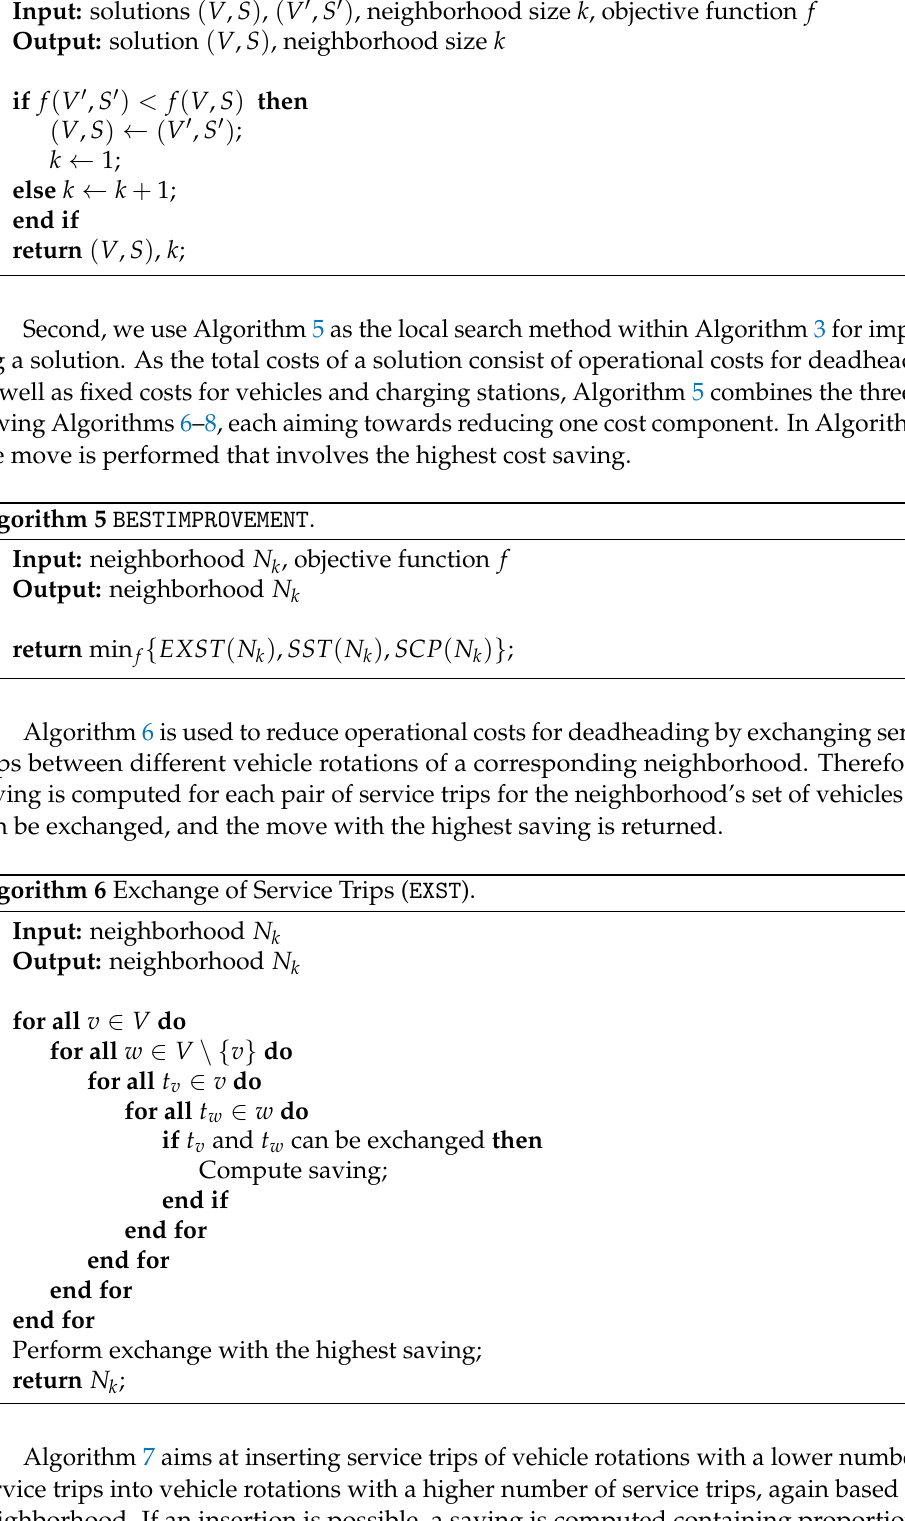
Algorithm 7 aims at inserting service trips of vehicle rotations with a lower number of service trips into vehicle rotations with a higher number of service trips, again based on